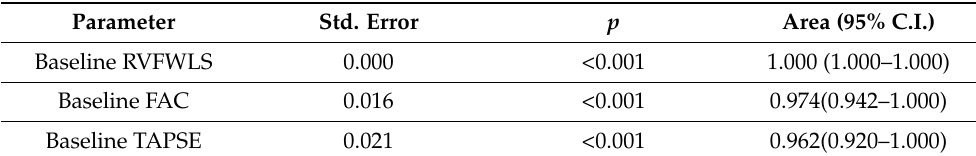
Table 4. ROC curve using RVFWLS, FAC, and TAPSE baseline values for the prediction of mortality.